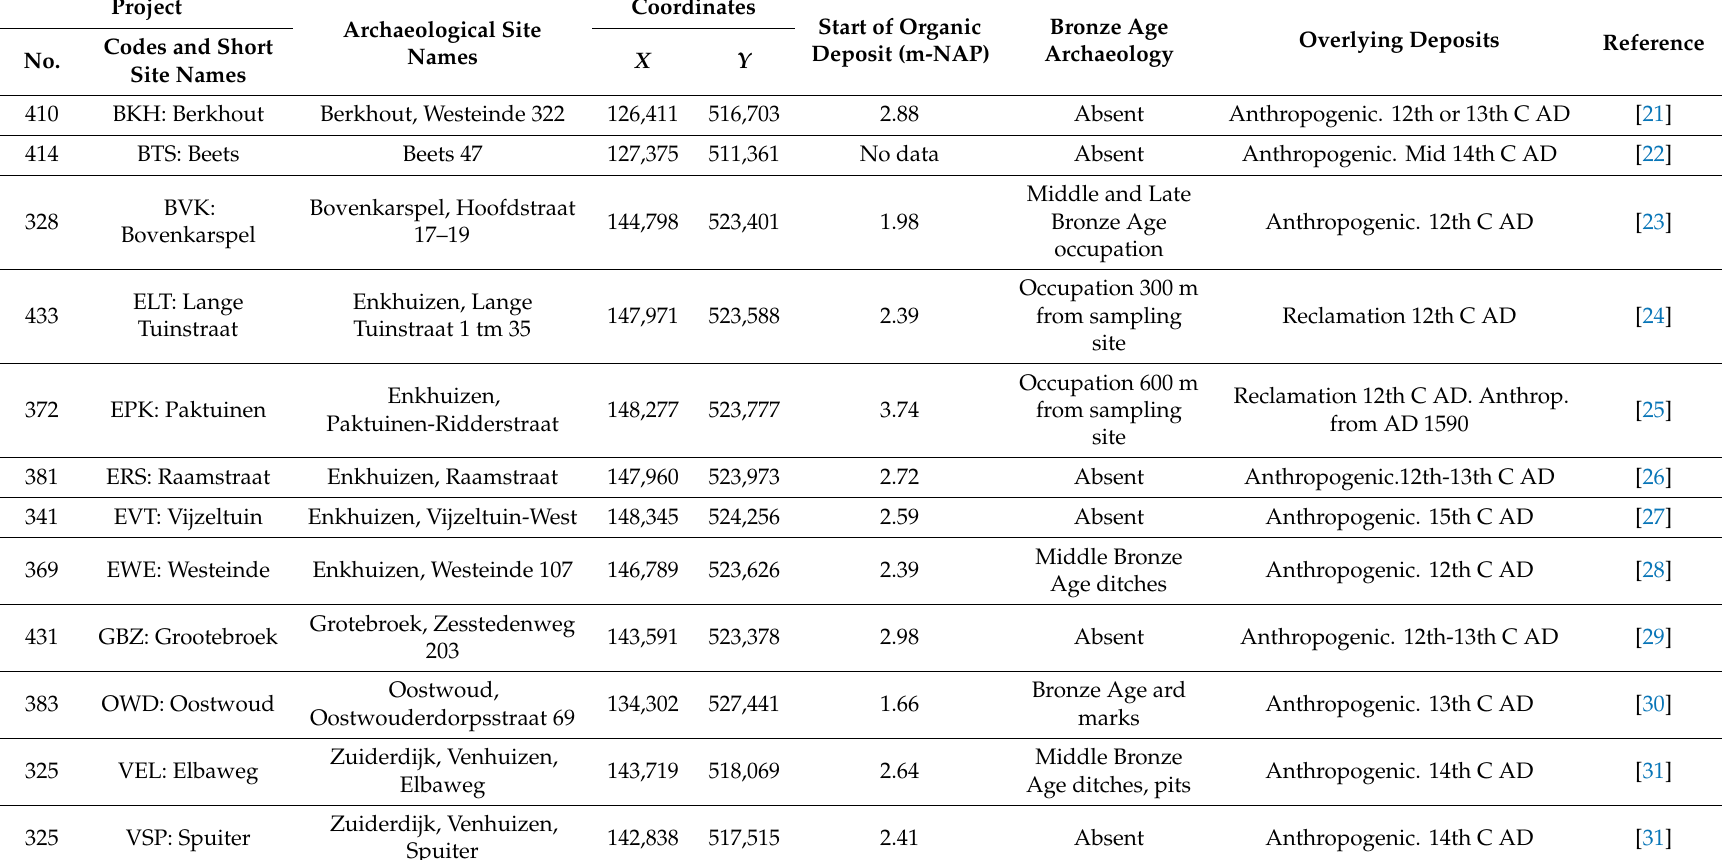
Table 1. Archeological project numbers, site names, coordinates, levels of starting organic deposits in meters below Dutch Ordnance Datum (NAP), evidence for nearby Bronze Age archaeology, overlying deposits and archaeological